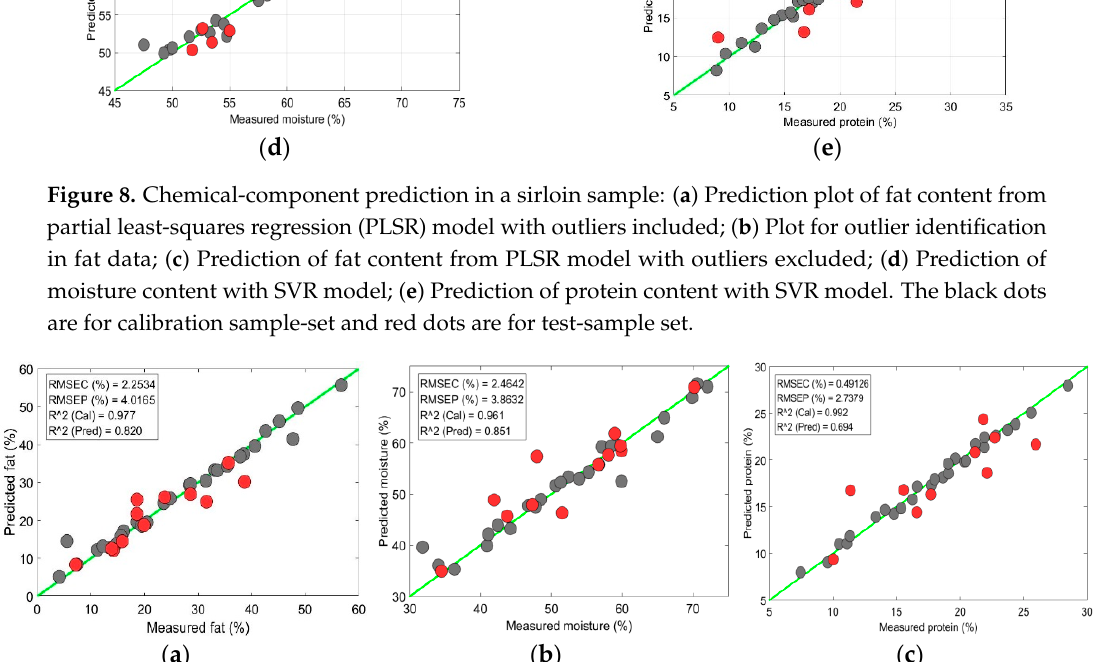
Figure 8. Chemical-component prediction in a sirloin sample: ( a ) Prediction plot of fat content from partial least-squares regression (PLSR) model with outliers included; ( b ) Plot for outlier identification in fat data; ( c ) Prediction of fat content from PLSR model with outliers excluded; ( d ) Prediction of moisture content with SVR model; ( e ) Prediction of protein content with SVR model. The black dots are for calibration sample-set and red dots are for test-sample set.